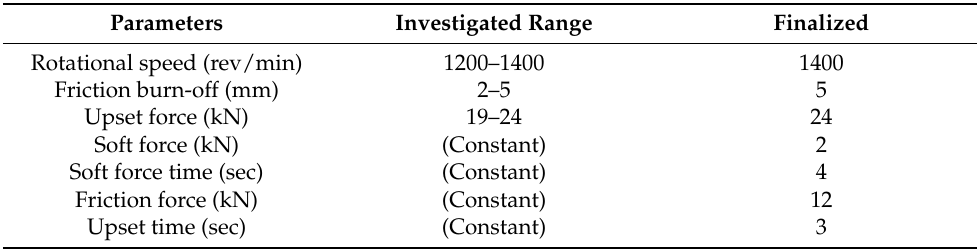
Table 3. Parameter employed for welding.